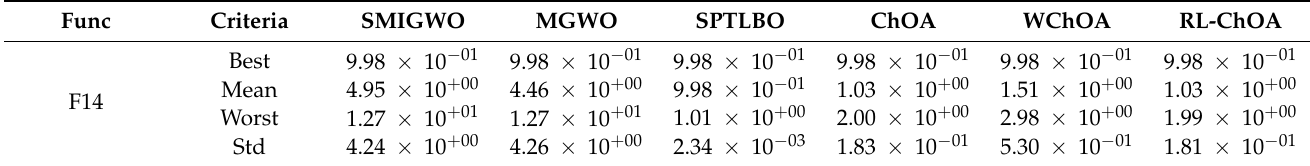
Table 4. Results of fixed-dimension multi-modal benchmark